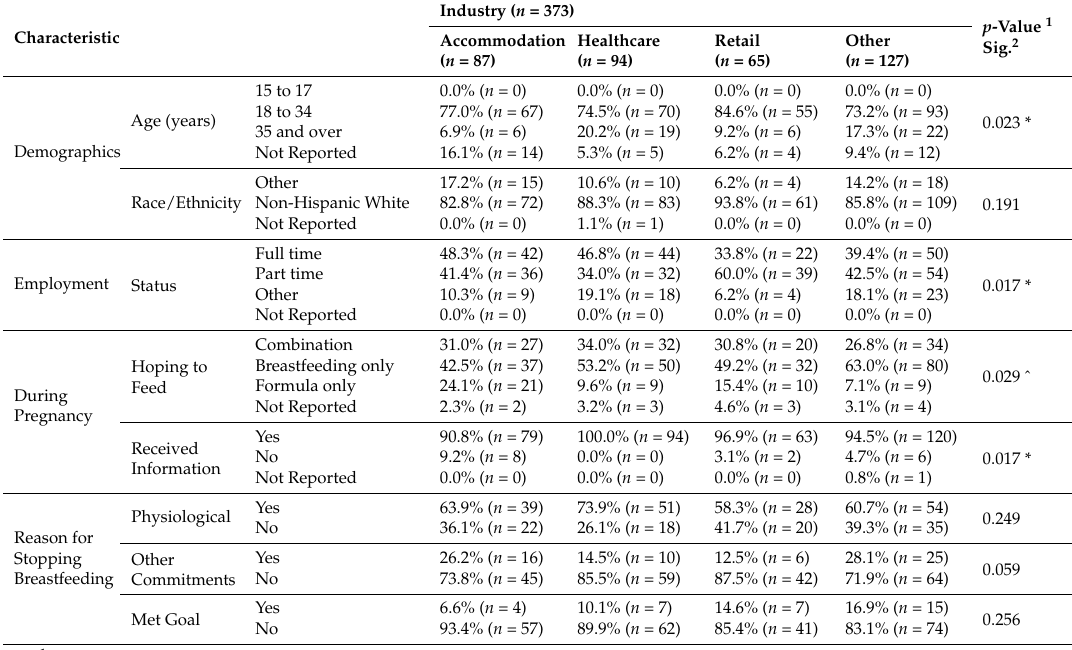
Table 5. Maternal Demographic, Employment, Pregnancy, and Breastfeeding Characteristics by Industry.